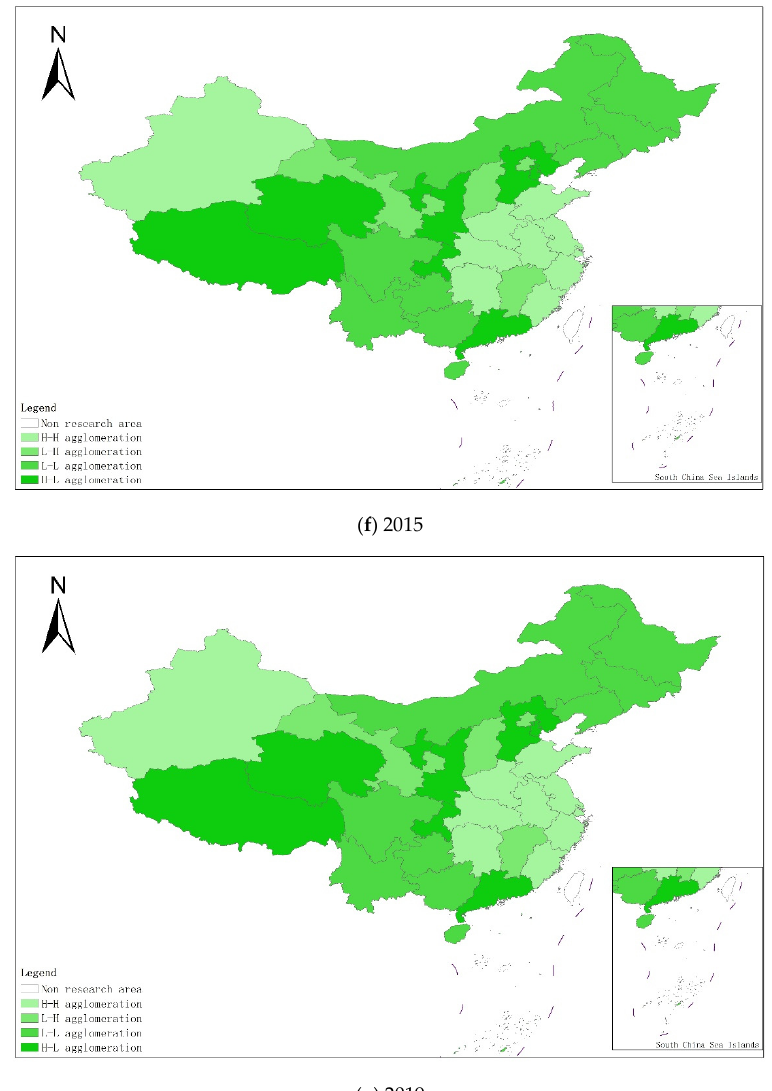
Figure 6. Province distribution of the Moran index of the coupling coordination degree of China’s industrialization and agricultural green development in some years ( a – g ). ( a ) 1990; ( b ) 1995; ( c ) 2000; ( d ) 2005; ( e ) 2010; ( f ) 2015; ( g ) 2019. Data Source: the authors calculated based on China Sta- tistical Yearbook, China Industrial Statistical Yearbook, China Rural Statistical Yearbook,